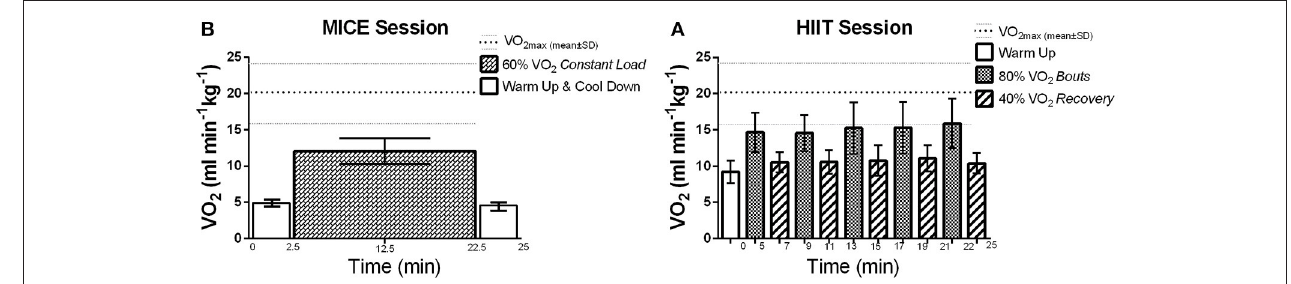
FIGURE 1 | Average VO 2 (ml min − 1 kg − 1 ) reached during exercise sessions: VO 2max : 20.44 ± 4.8ml min − 1 kg − 1 , mean is represented by the thick dotted line and standard deviation (SD) is represented by the thinner dotted line. (A) HIIT session: At 40% VO 2 : 10.68 ± 1.6ml min − 1 kg − 1 (52.24 ± 1.3% of VO 2max ), and; at 80% VO 2 : 15.12 ± 2.9ml min − 1 kg − 1 (74 ± 2.59% of VO 2max ). (B) MICE session: at 60% VO 2 : 12.06 ± 1.8ml min − 1 kg − 1 (59.02 ± 1.8% of VO 2max